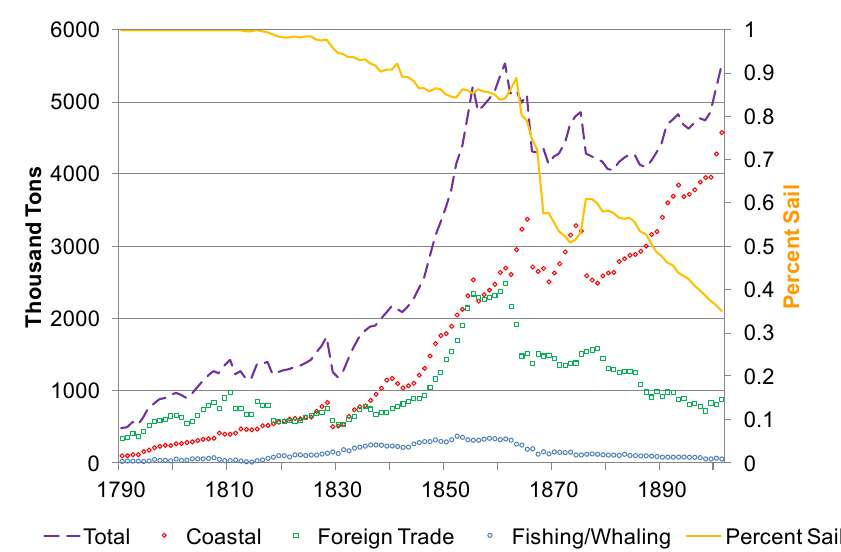
Figure 3. U.S. maritime fleets, 1790–1901. Sources: Sailing tonnage from [6]. Calculations of energy input from [9].